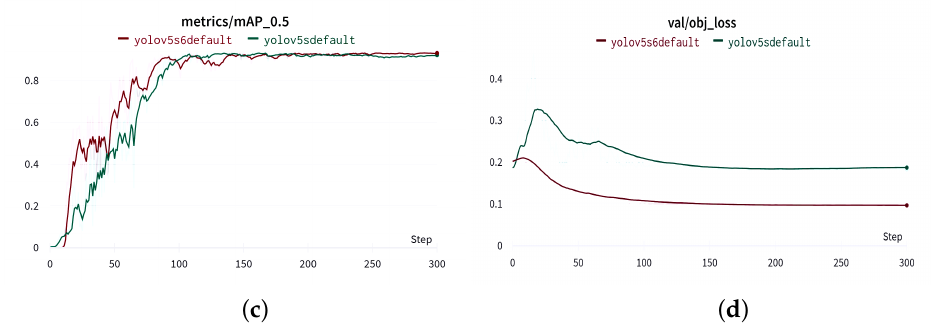
Figure 15. Results of validation phase using YOLOv5-s and YOLOv5-s6. ( a ) precision, ( b ) recall, ( c ) mAP@0.5 and ( d ) objectness loss.